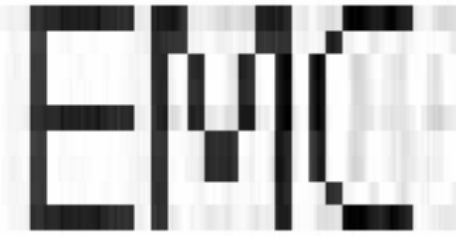
Figure 13. Reconstructed image from common-mode noise for 1280 × 1024 pixels monitor